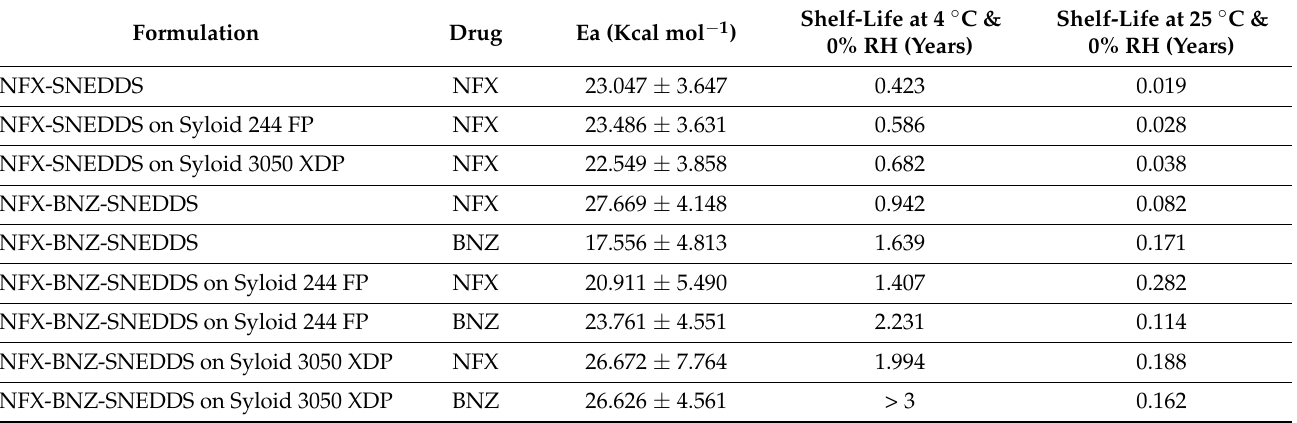
Table 5. Shelf-life prediction based on first order degradation fitted to accelerated stability data for liquid and solid SNEDDS (NFX SNEDDS, NSS1, NSS2, NFX and BNZ SNEDDS, NBSS1, NBSS2) over five temperatures (25, 40, 60, 70, 80 ◦